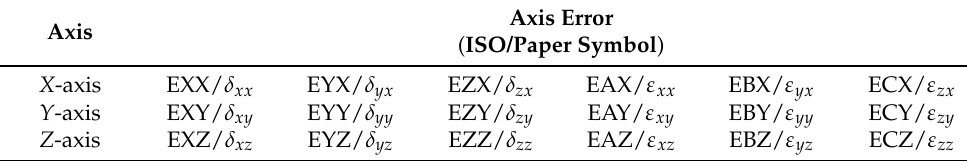
Table 3. Geometric errors for three-axis MT.